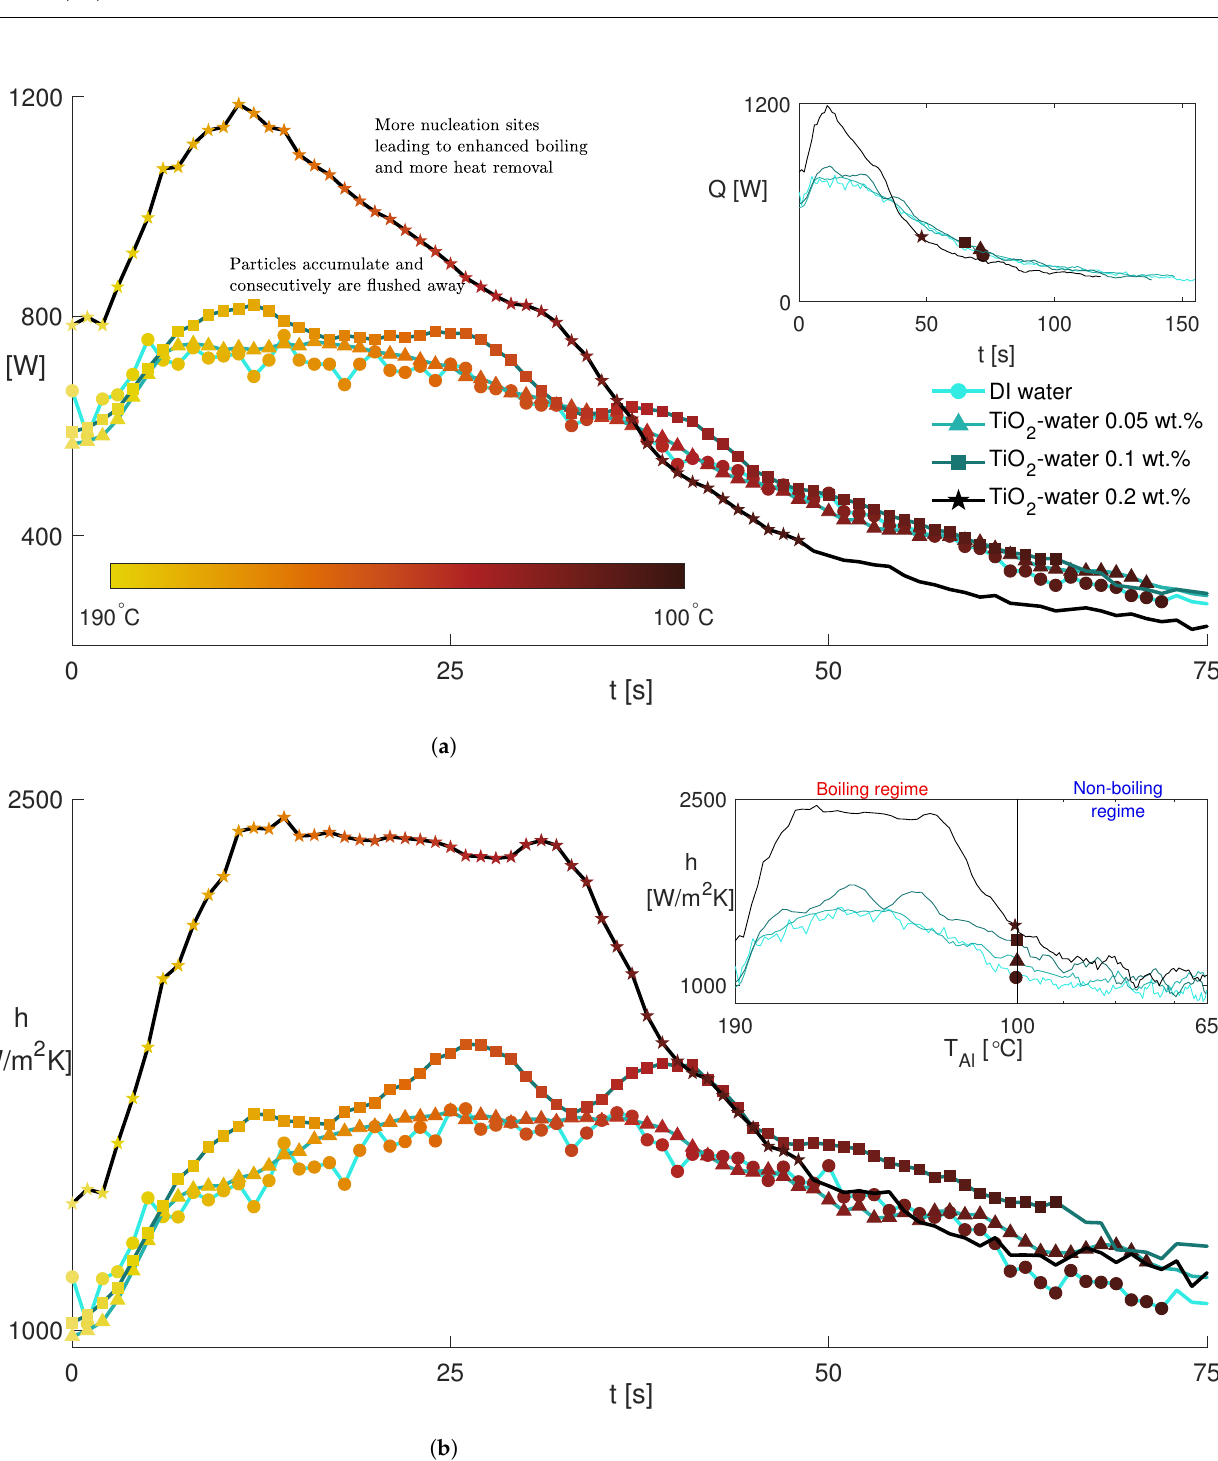
Figure 6. ( a ) Heat transfer rate from the aluminum block to the spray as a function of time. ( b ) Tem- poral evolution of the heat transfer coefficient of the spray. Both insets display the whole cooling process from 190 to 65 ◦ C, whereas only the boiling regime is expressed in the main figures. To give insight into the cooling process, a temperature colormap is applied to the markers to highlight the boiling regime (190 ◦ C and 100 ◦ C). The same legend applies to all